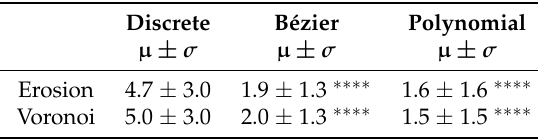
Table 7. Mean relative error of the length measurement methods in % after the centerline extraction by both methods and the spatial interpolation compared to the ground truth for the experimental data set (mean also over all angles). Significance was proven for the reduction of the error compared to the discrete length for each function type ∗∗∗∗ p < 0.0001. Angle resolved relative errors are given in Tables 8 and 9.